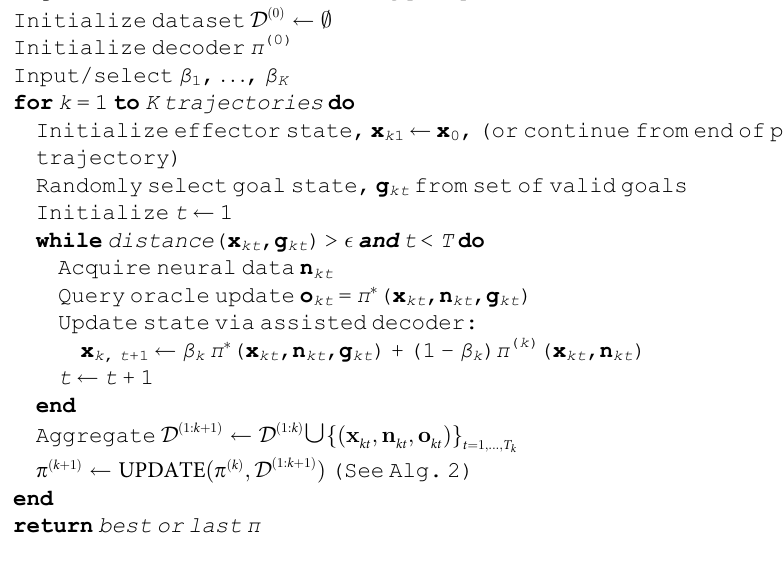
Algorithm 1: Imitation learning perspective of decoder